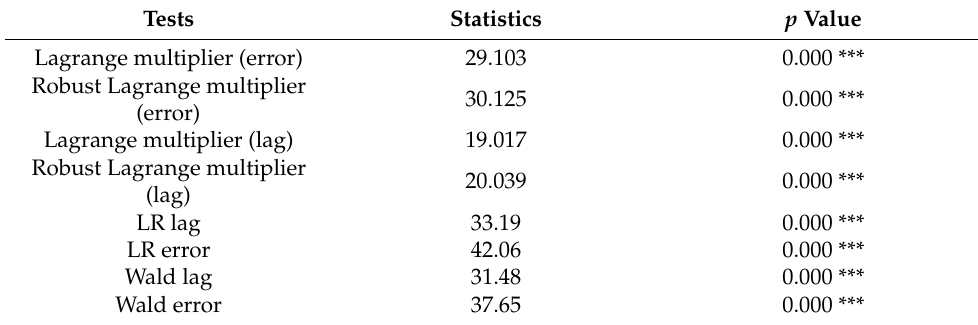
Table 4. Test results of LM, LR, and Wald.